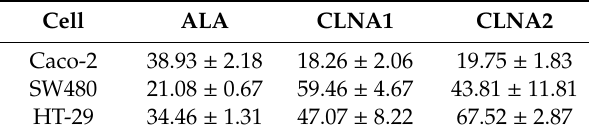
Table 1. The IC 50 of ALA, CLNA1, and CLNA2 on three colon cancer